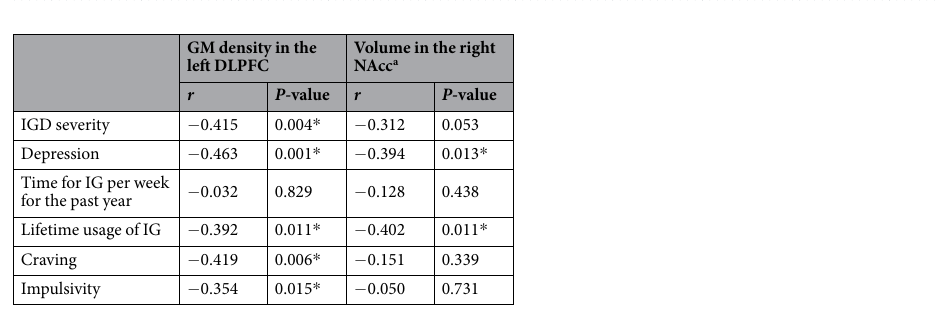
Table 3. The relationship between the volumetric measurements and IGD characteristics. Abbreviations: DLPFC, dorsolateral prefrontal cortex; GM, gray matter; IG, Internet gaming; IGD, Internet gaming disorder; NAcc, nucleus accumbens. a A partial correlation analysis was conducted, adjusting for age and estimated total intracranial volume (eTIV) as covariates. * Significant at P <